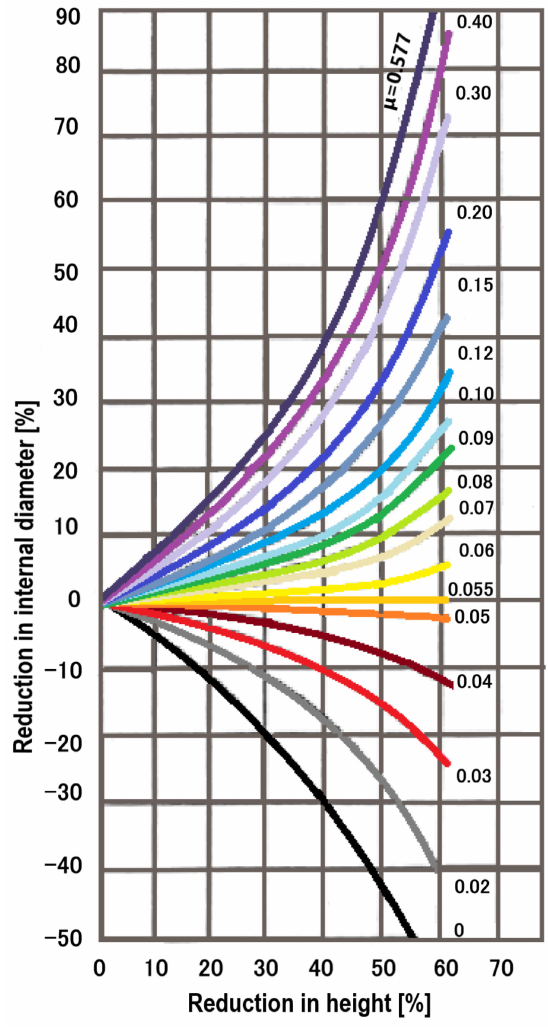
Figure 5. Friction calibration curves.